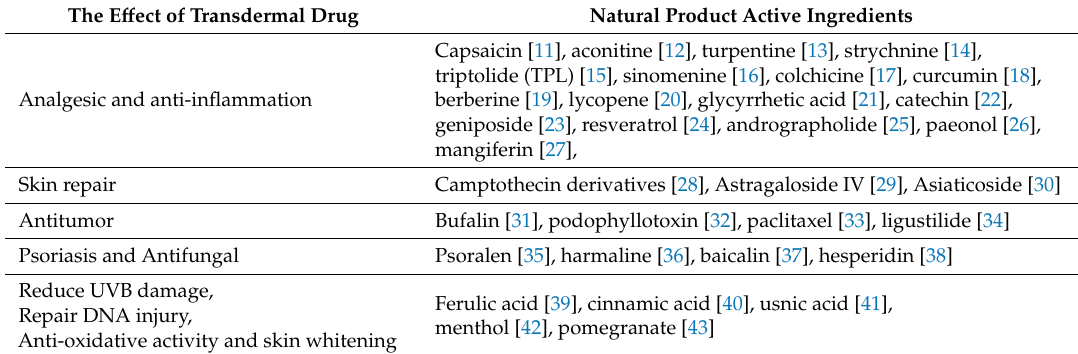
Table 1. Examples of transdermal natural product